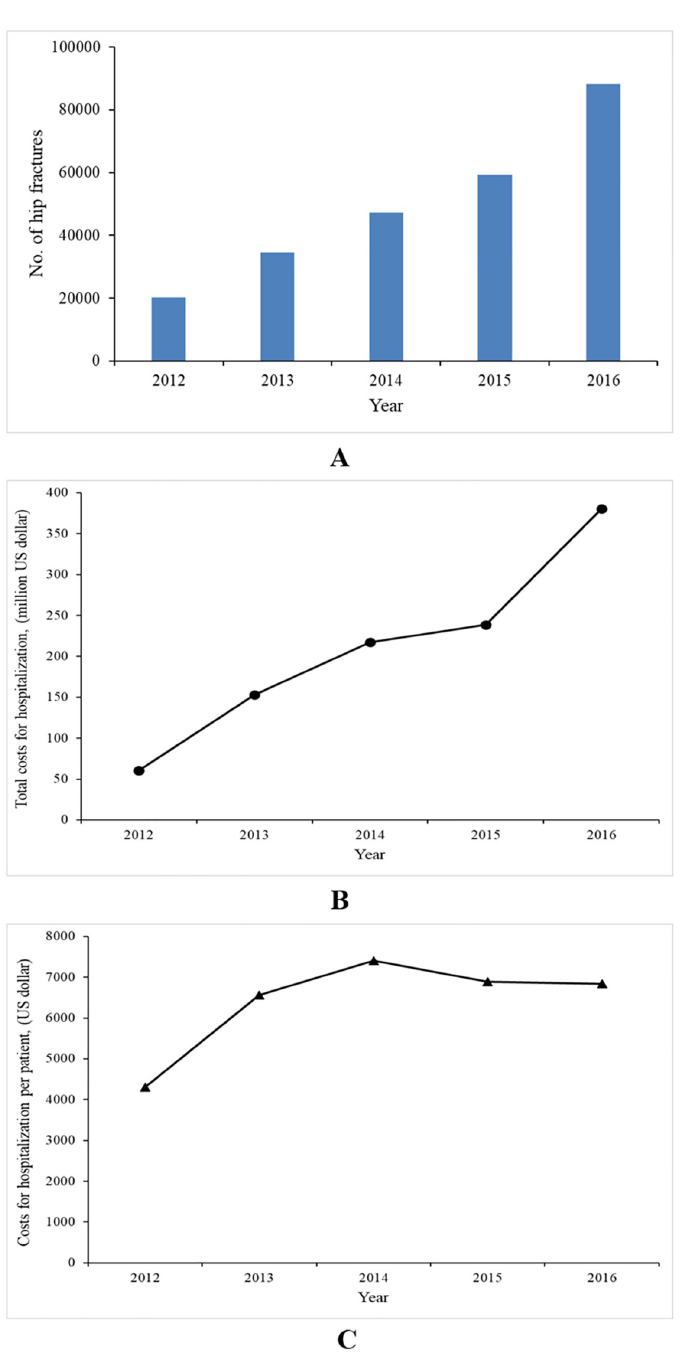
Fig 3. Annual number of hip fracture patients and associated costs for hospitalization (in US dollars). (A) Annual number of hip fractures. (B) Total costs for hospitalization. (C) Costs for hospitalization per patient. Costs were discounted by the consumer price index (CPI) in each year to 2016 costs and converted into US dollars based on the 2016 RMB to US dollar exchange rate (period average). The CPI and exchange rate were from China Statistical Yearbook